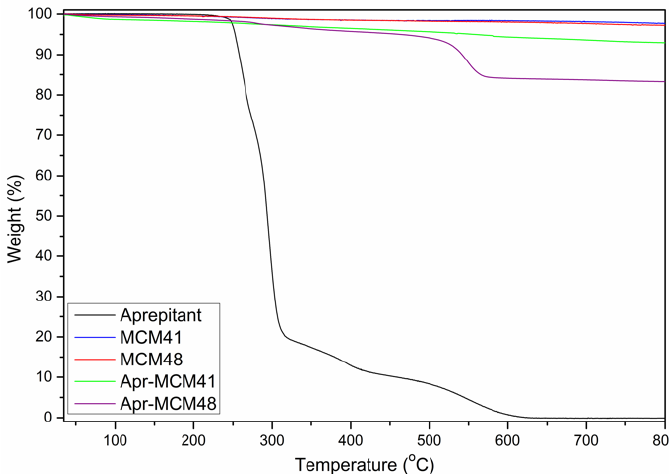
Table 1. Drug loading and encapsulation efficiency values determined by the HPLC method.